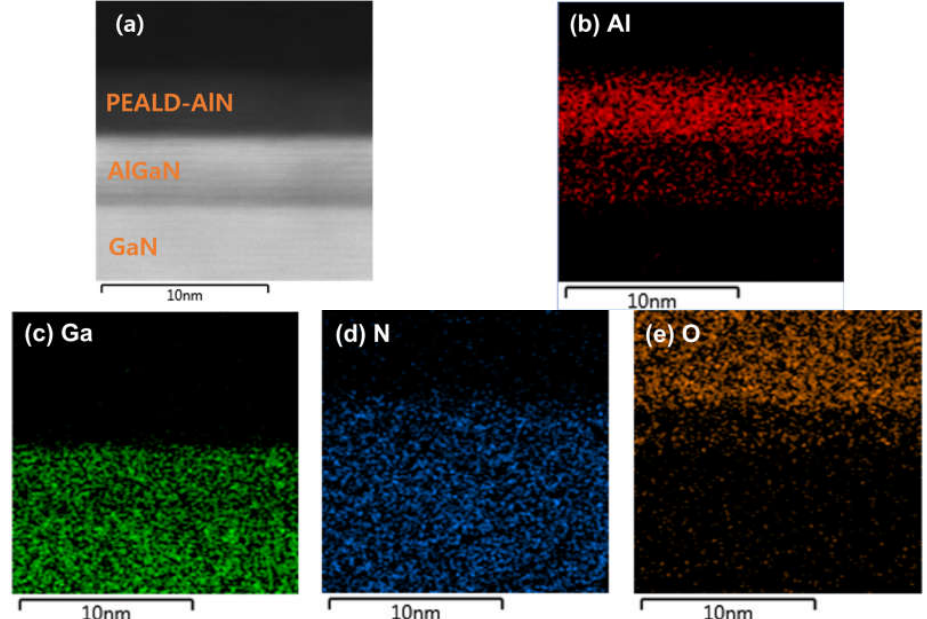
Figure 4. Element distribution of PEALD AlN film/AlGaN/GaN heterostructure analyzed by TEM- EDX mapping; ( a ) cross-sectional view, ( b ) aluminum, ( c ) gallium, ( d ) nitrogen, and ( e ) oxygen.